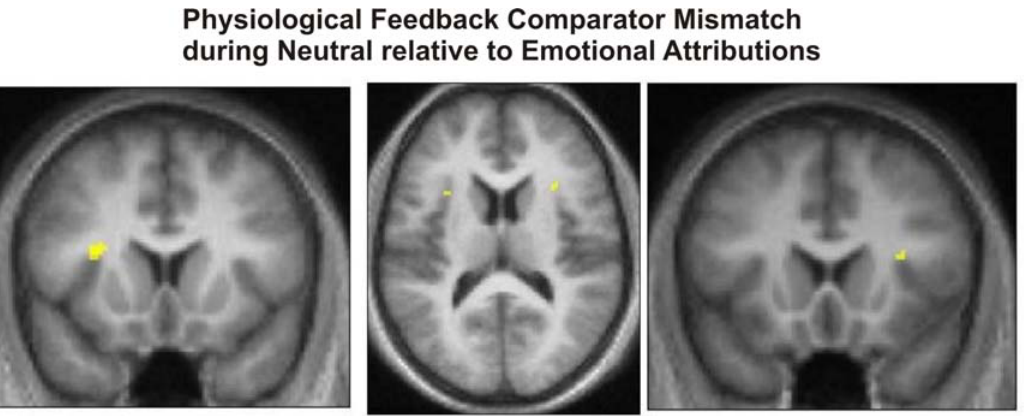
Figure 3. Neural activity associated with physiological comparator mismatch. During rating of neutral expressions, greater bilateral anterior insula activity was observed during asynchronous rather than synchronous cardiac feedback, relative to the same difference during ratings of happy expressions. Results are projected onto the normalised mean structural T1 weighted image.